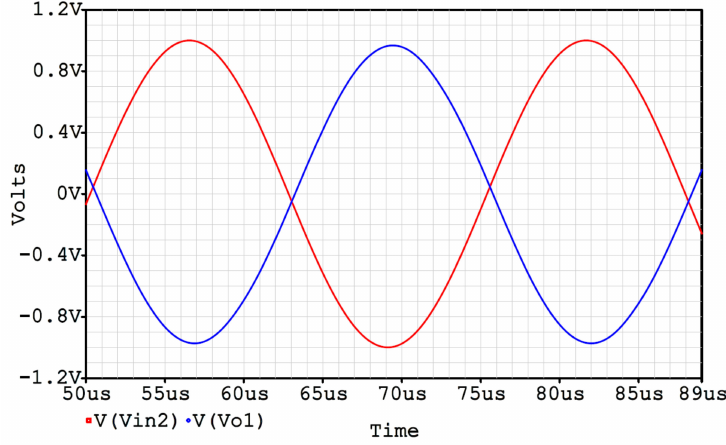
Figure 14. Time domain response of the IBP filter at V o1 when V i1 = 0 and V i2 = V in .